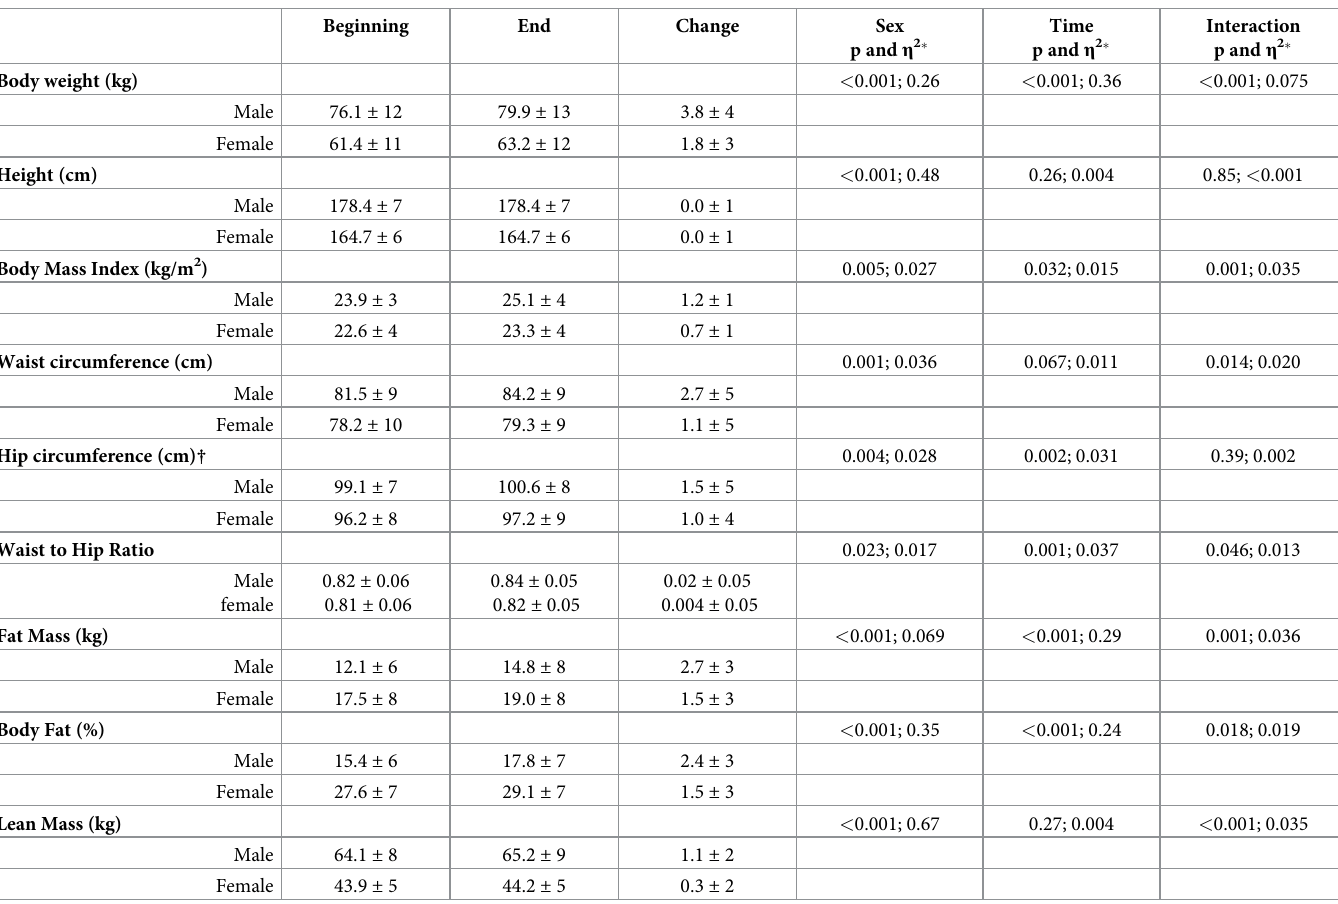
Table 1. Anthropometric and body composition data from beginning to end of first-year university in male (n = 72) and female (n = 229)